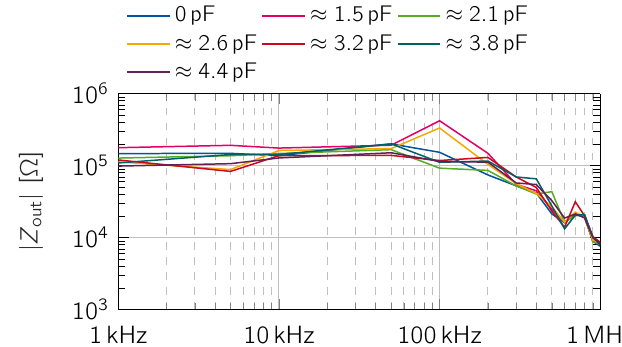
Figure 9: Measured output impedance of the symmetrical EHCS for different values of C c : Between 1 kHz and 50 kHz, the output impedance is for all values of C c in the range of 100 - 200 k (cid:10) . After 100 kHz, the impedance drops for all measurements just below 10 k (cid:10) .